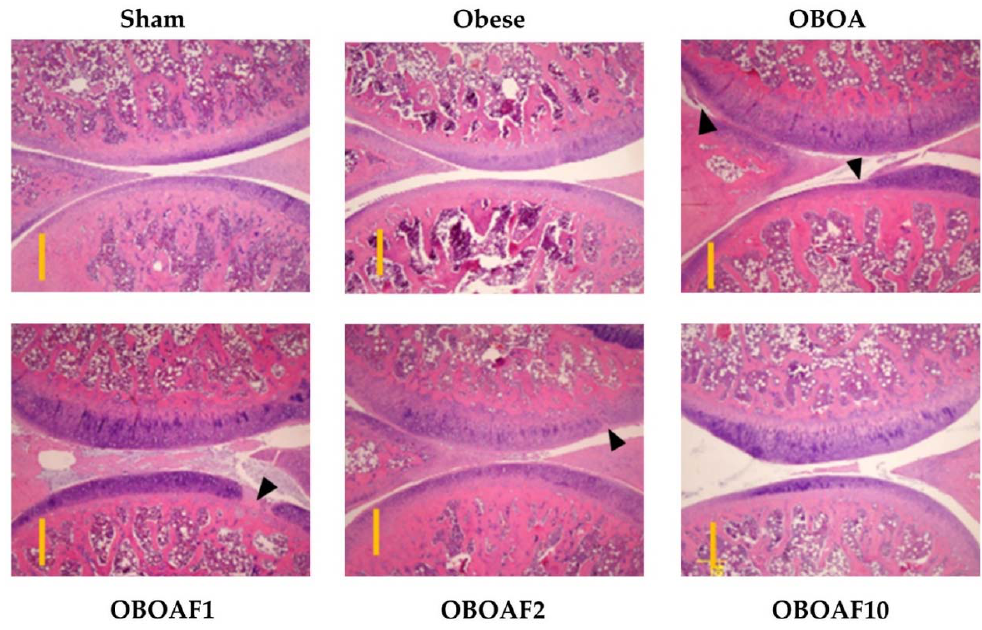
Figure 4. The histopathological difference between the knee joints in the HFD-induced obese male rats with ACLT + MMx surgery induced OA using Hematoxylin and Eosin stains. The representative cartilage sections from the right medial condyle of the femur and tibia were stained. The specimens were observed with 40× magnification. The scale bar length is 500 μ m.